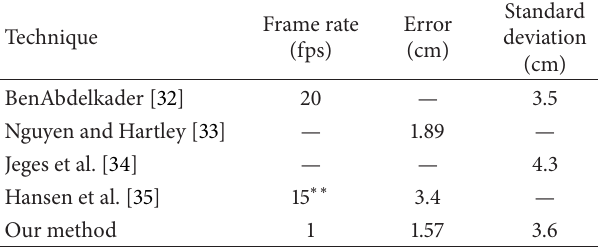
Table 1: Comparison of results of height estimation in